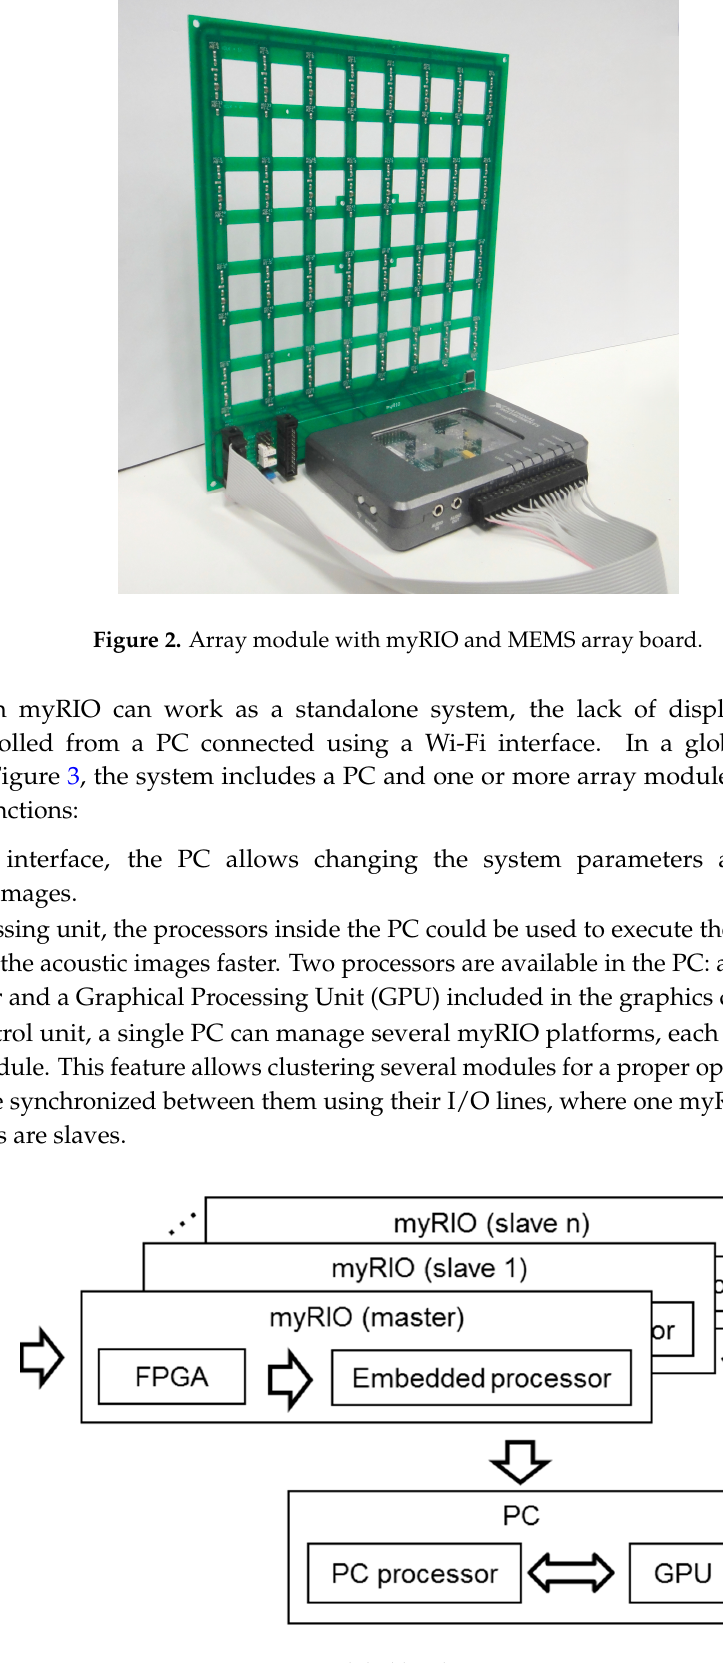
Figure 3. Global hardware setup.